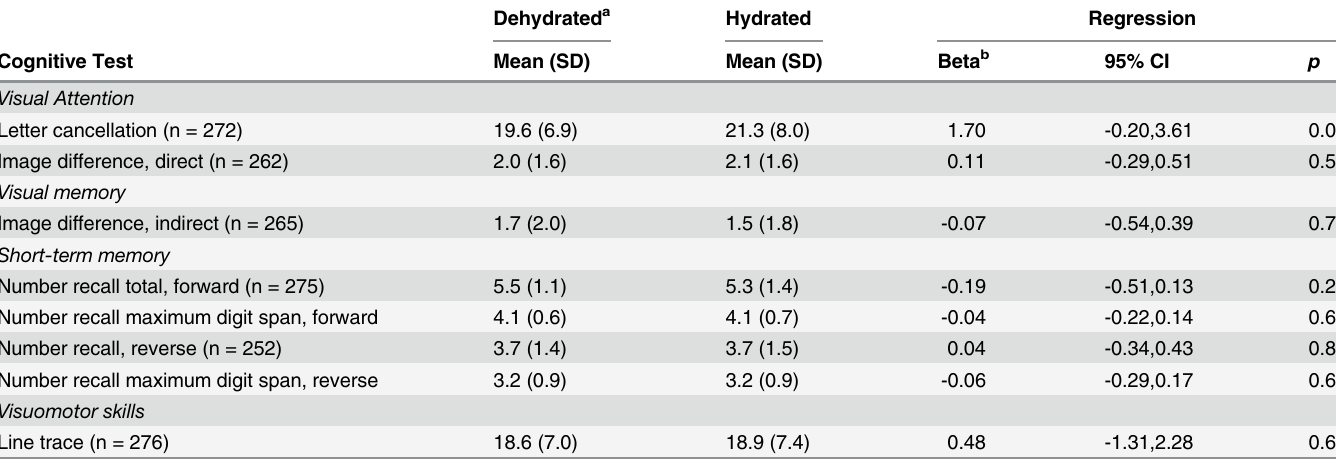
Table 5. Mean and standard deviation (SD) of cognitive tests by dehydration status, with multivariable linear regression models of the association between dehydration and cognitive performance among pupils in Zambia. Dehydrated a Hydrated